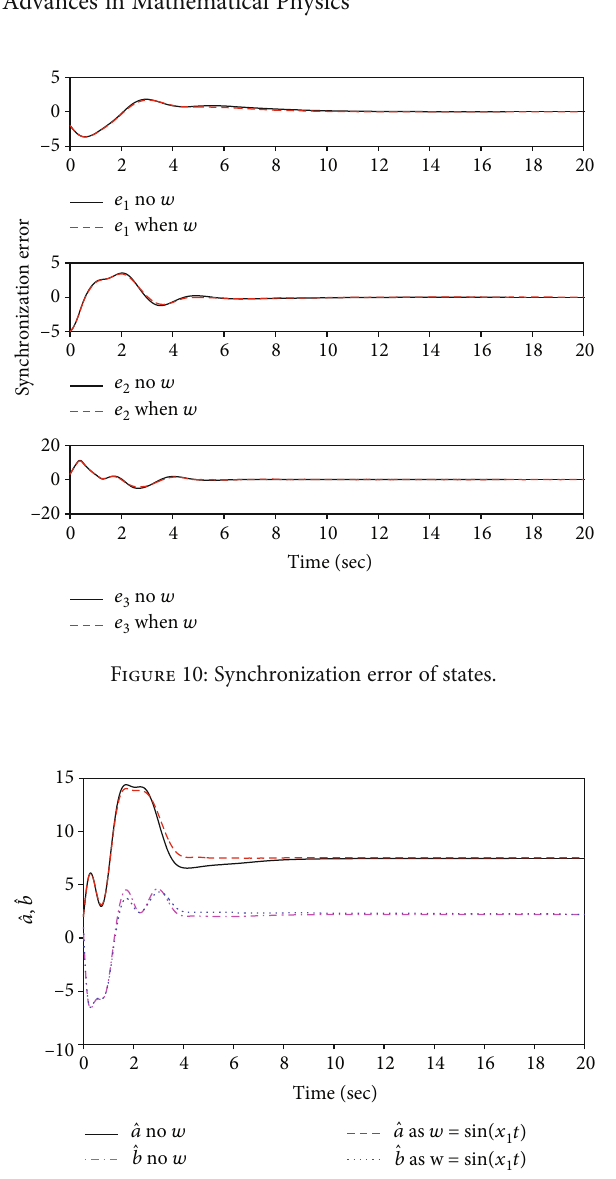
Figure 11: Time response of the parameter estimates.